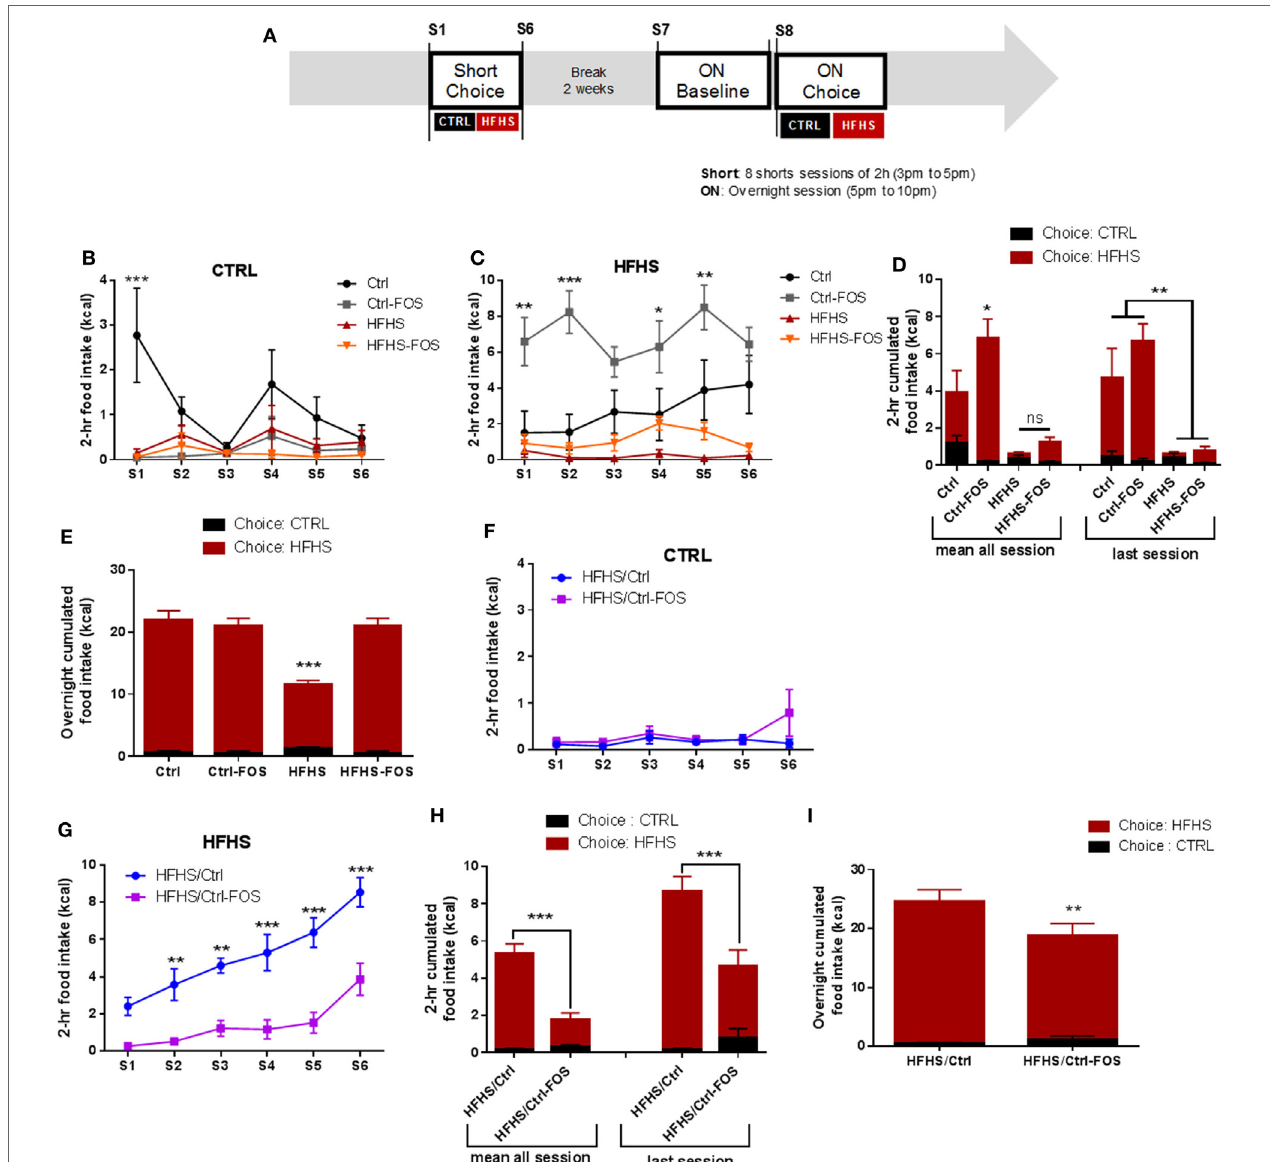
FigUre 2 | (a) Experimental design for food tropism analysis using short or overnight access to a two-food choice protocol using regular chow diet or palatable HFHS diet for six mice per group. Regular chow diet [CTRL (B,D,F,h) ] or HFHS intake (c,D,g,h) during seven sessions consisting of a 2-h two-food choice access, (D,h) representative tropism for CTRL vs HFHS as average cumulated intake through all session or during the last session, (e,i) representative tropism for CTRL vs HFHS as average cumulated intake overnight in Ctrl (black), Ctrl-fructo-oligosaccharides (FOS) (gray), HFHS (red), HFHS-FOS (orange), HFHS/Ctrl (blue), and HFHS/ Ctrl-FOS (purple). Data are expressed as mean ± SEM of six mice in each group. Significant differences from a two-way ANOVA, Bonferroni Post hoc test (* P < 0.005, ** P < 0.001, *** P < 0.0005) (B–i)